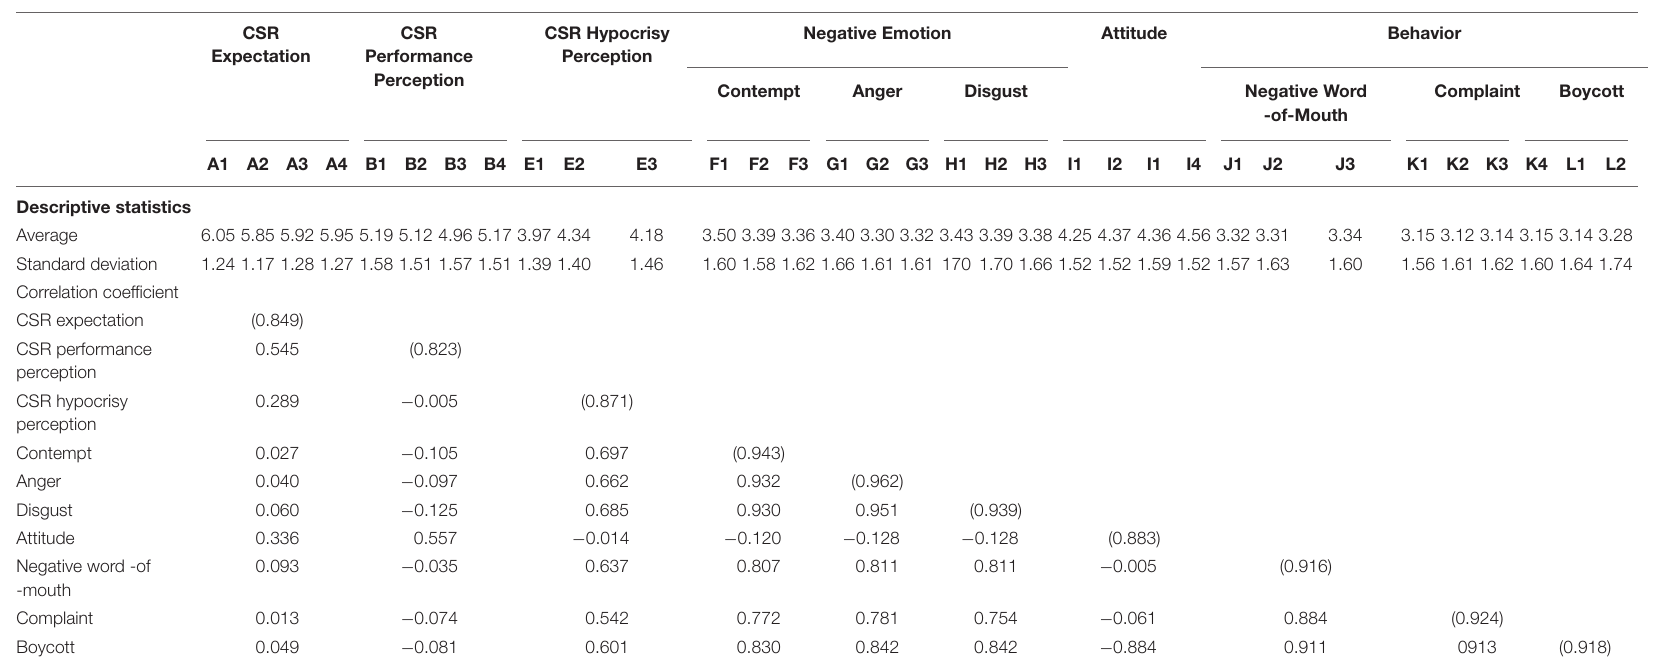
TABLE 4 | Latent variable relationships.